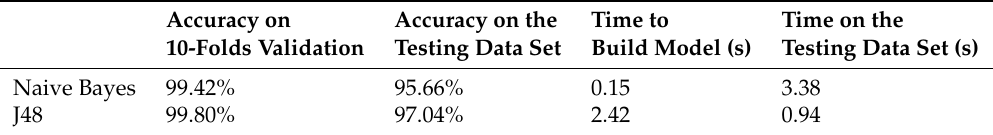
Table 7. Accuracy and runtime of J48 and Naive